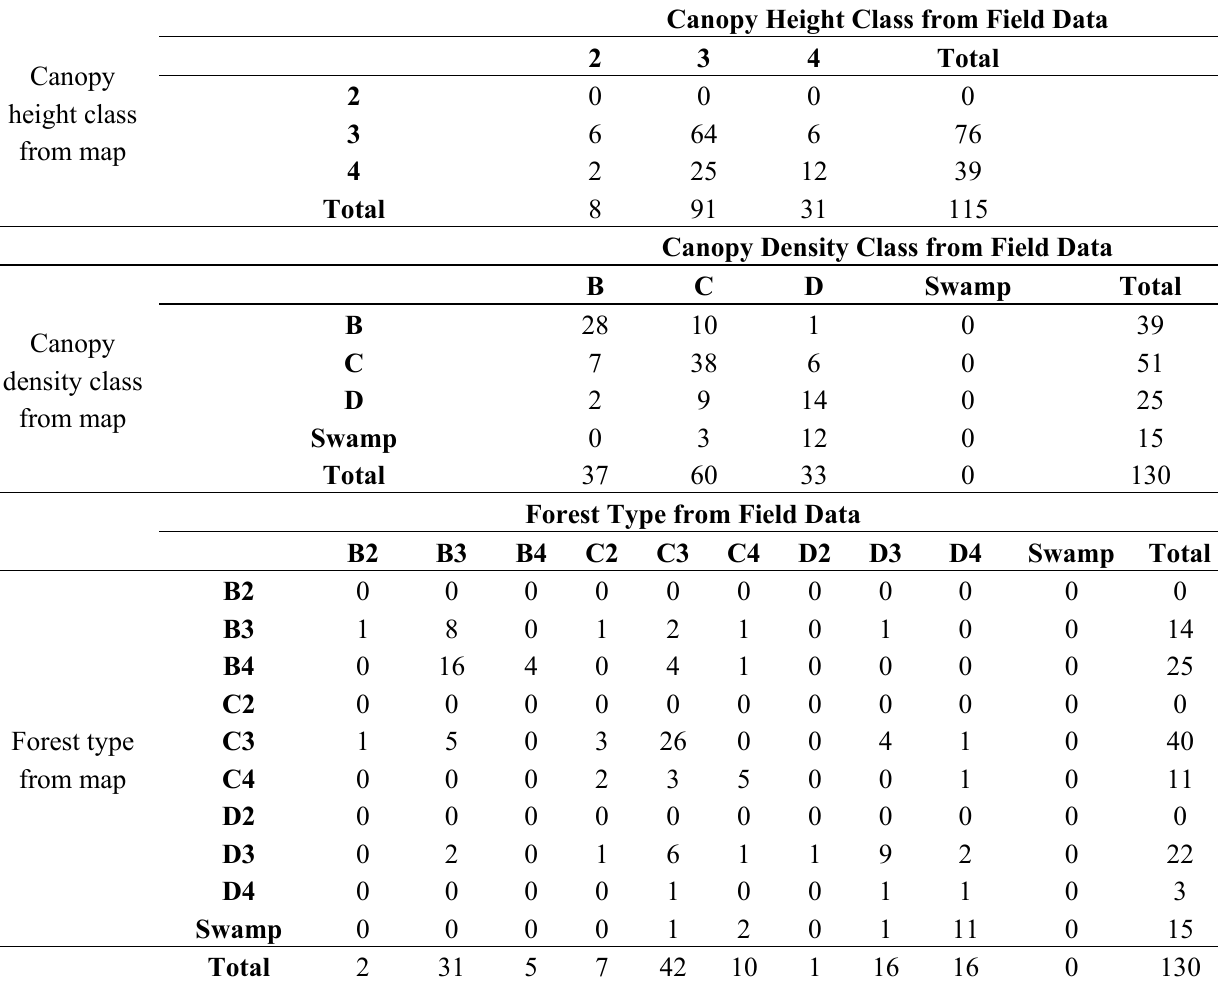
Table 2. Comparison of the map and field classification of stand height, stand density and forest type. Note that swamps were not included in the height class comparison, resulting in an N of 115. The number of stands in each forest type by interpreted and field data are represented by the row and column tables. Classifications were compared with the Cohen Kappa Test. Value for height class was 0.12, for density class was 0.44, and for forest type